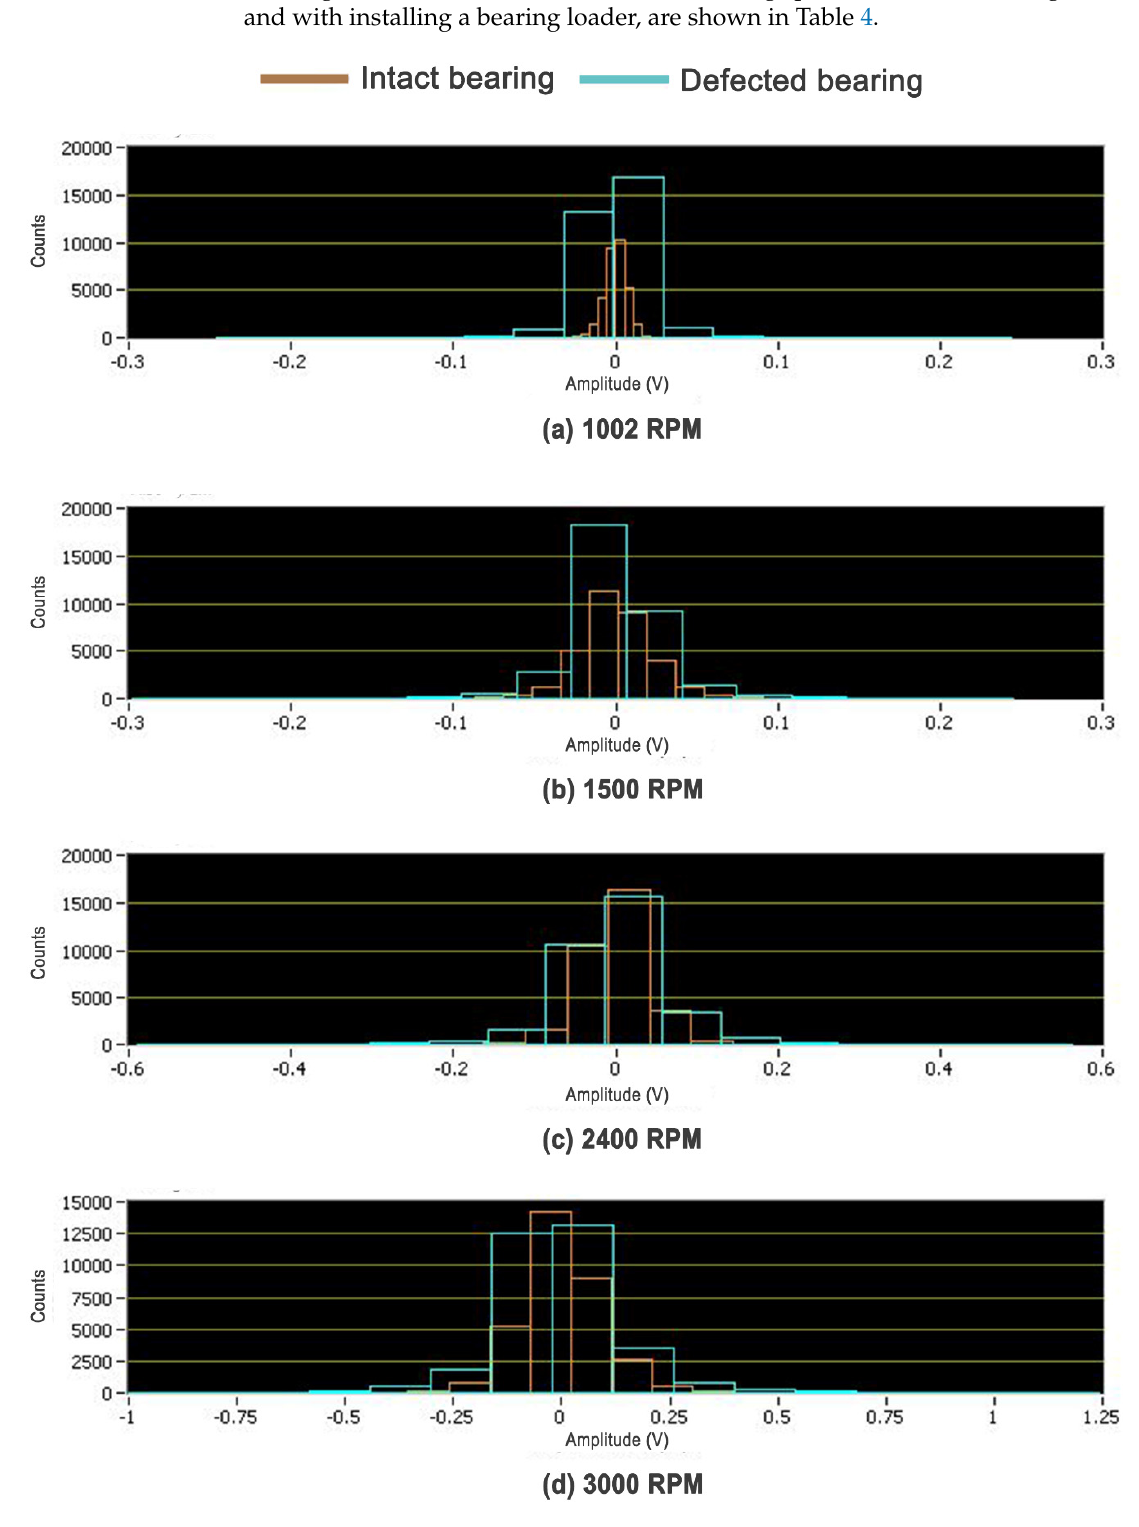
Figure 2. Histograms for an inner race damaged bearing without installing a bearing loader.